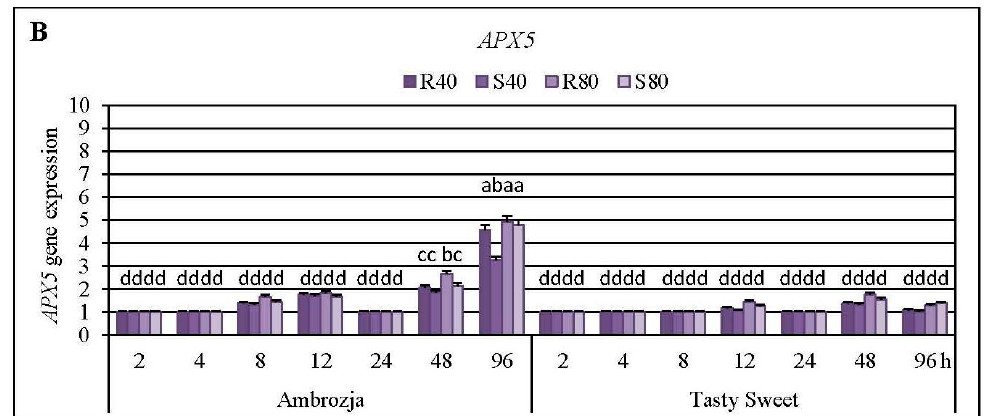
Figure 4. Influence of the cereal aphid’s infestation on relative expression of APX4 ( A ) and APX5 ( B ) genes in the seedlings of Ambrozja and Tasty Sweet maize varieties (first phase of the experiments). R40, R80—maize plants of a certain genotype infested with 40 or 80 R. padi females per seedling, accordingly; S40, S80—maize plants of a certain genotype infested with 40 or 80 S. avenae females per seedling, respectively. All data are presented as the mean (±SD) of three independent biotests, and significant differences in abundance of the APX transcripts are denoted by different letters ( p < 0.05; post-hoc Tukey’s test).